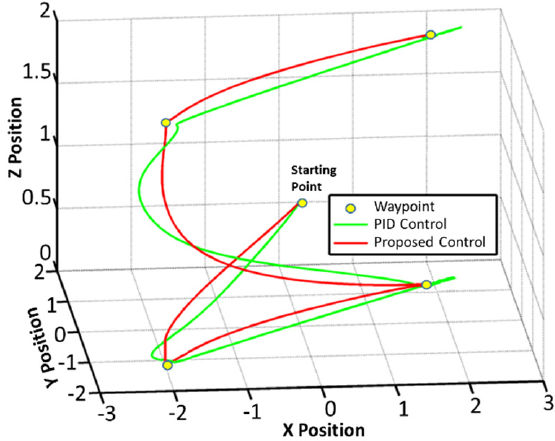
Figure 15. Performance of the aerial robot in tracking waypoints. From the results of the experiments, it can be observed that the robot with the pro- posed controller provided smoother trajectory. Furthermore, the error in the trajectory tracking of the robot with the proposed controller was less than that of the PID controller. The results showed that the proposed control algorithm is able to stabilize the system performance when the robot is subjected to weight disturbances. It must be noted that the performance of the conventional PID controller was satisfactory as long as the extra weight was low, but when the added weight was large, the basic PID controller failed to control the robot